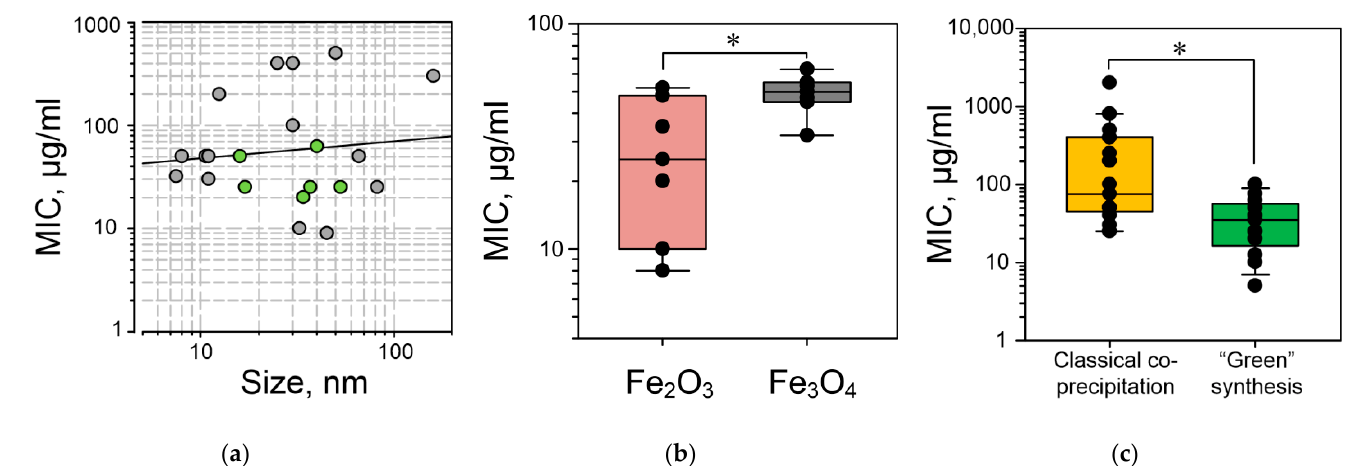
Figure 2. ( a ) Assessment of the dependence of the IONP MIC against E. coli on the IONP size. ( b ) Assessment of the dependence of the IONP MIC against E. coli on the iron oxide type. ( c ) Assessment of the dependence of the IONP MIC against E. coli in the synthesis method. Values of the minimum inhibitory concentrations are taken from the sources in Table 2. In ( a ), the grey color shows the values for the IONPs obtained without “green synthesis”, and the green color shows the values for the IONPs obtained by “green synthesis”. *— p < 0.05 by the Mann–Whitney U test.